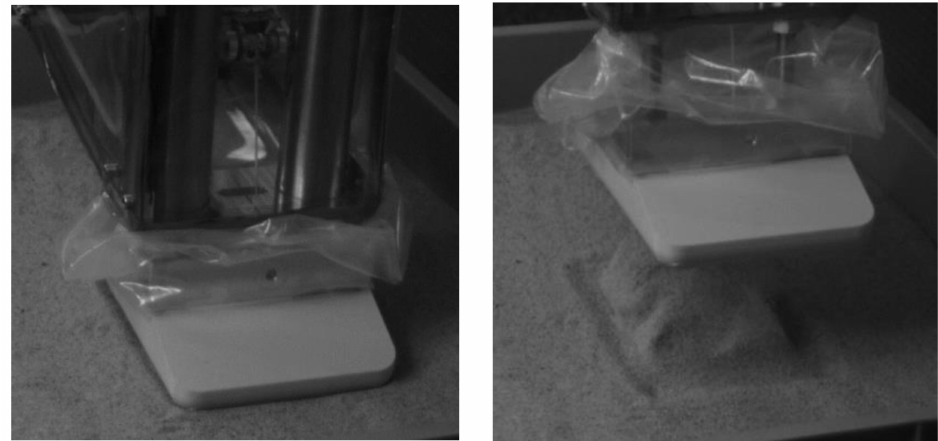
Figure 21. Jump in quartz sand with the foot in configuration #4.